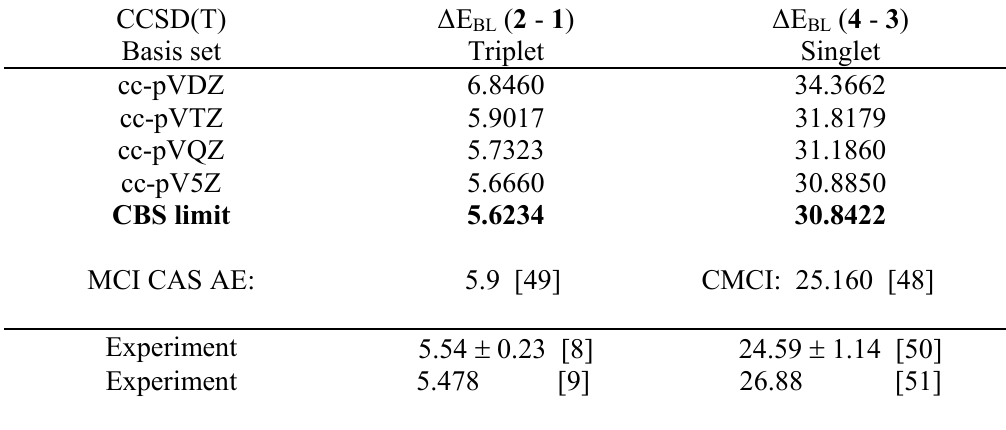
(difference of energies 2 ( ∆ E of bent 4 and linear 3 2